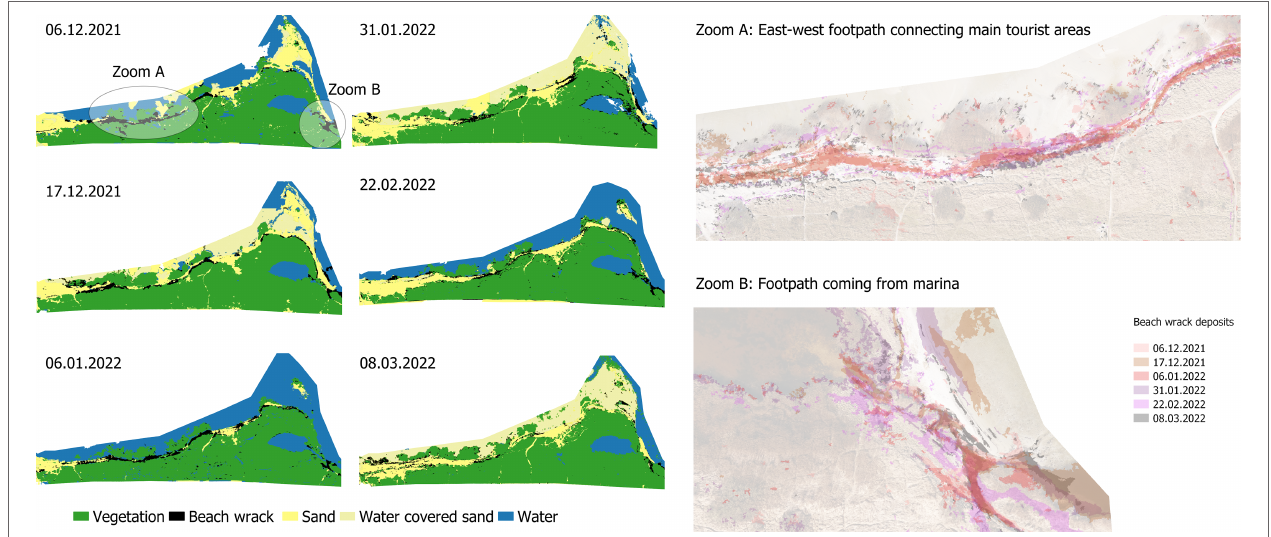
FIGURE 4 | Classification results for the UAV imagery from December 2021 to April 2022. Regardless of weather or water level conditions, beach wrack accumulations could always be mapped in two hotspot areas: along the east-west footpath connecting the main tourist areas ( Zoom A ) and within the area between the beach lake outlet and the footpath coming from the marina in the east ( Zoom B